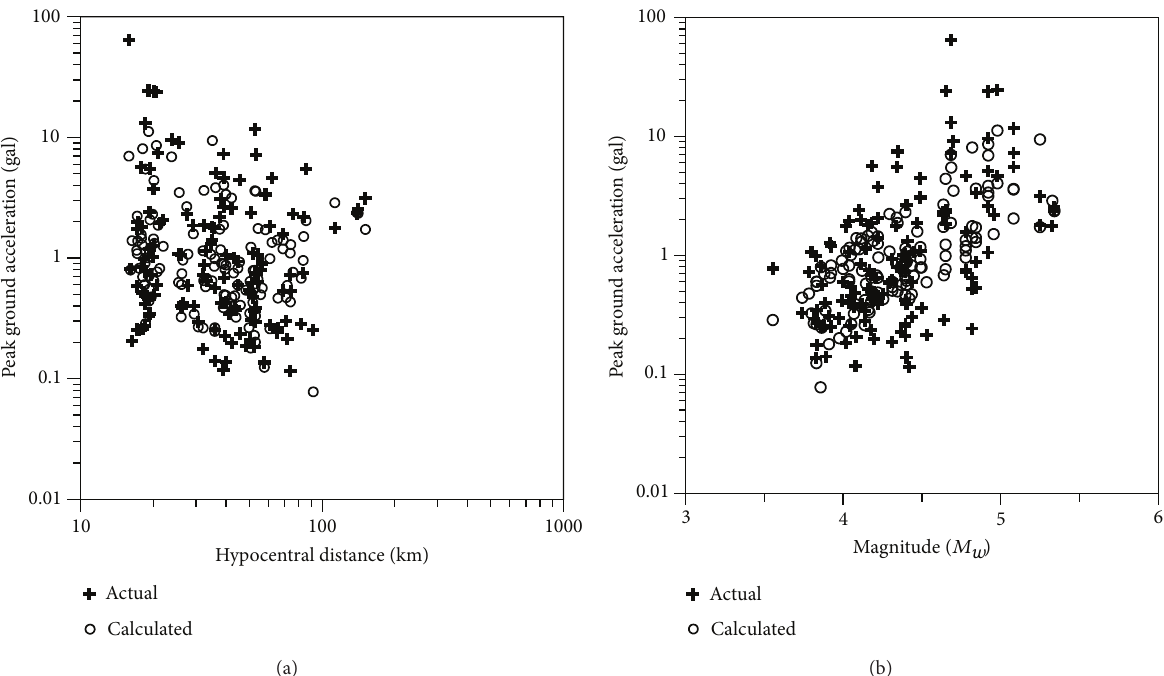
Figure 4: Comparison of observed peak ground acceleration with calculated peak ground acceleration for Kumaon Himalaya region.